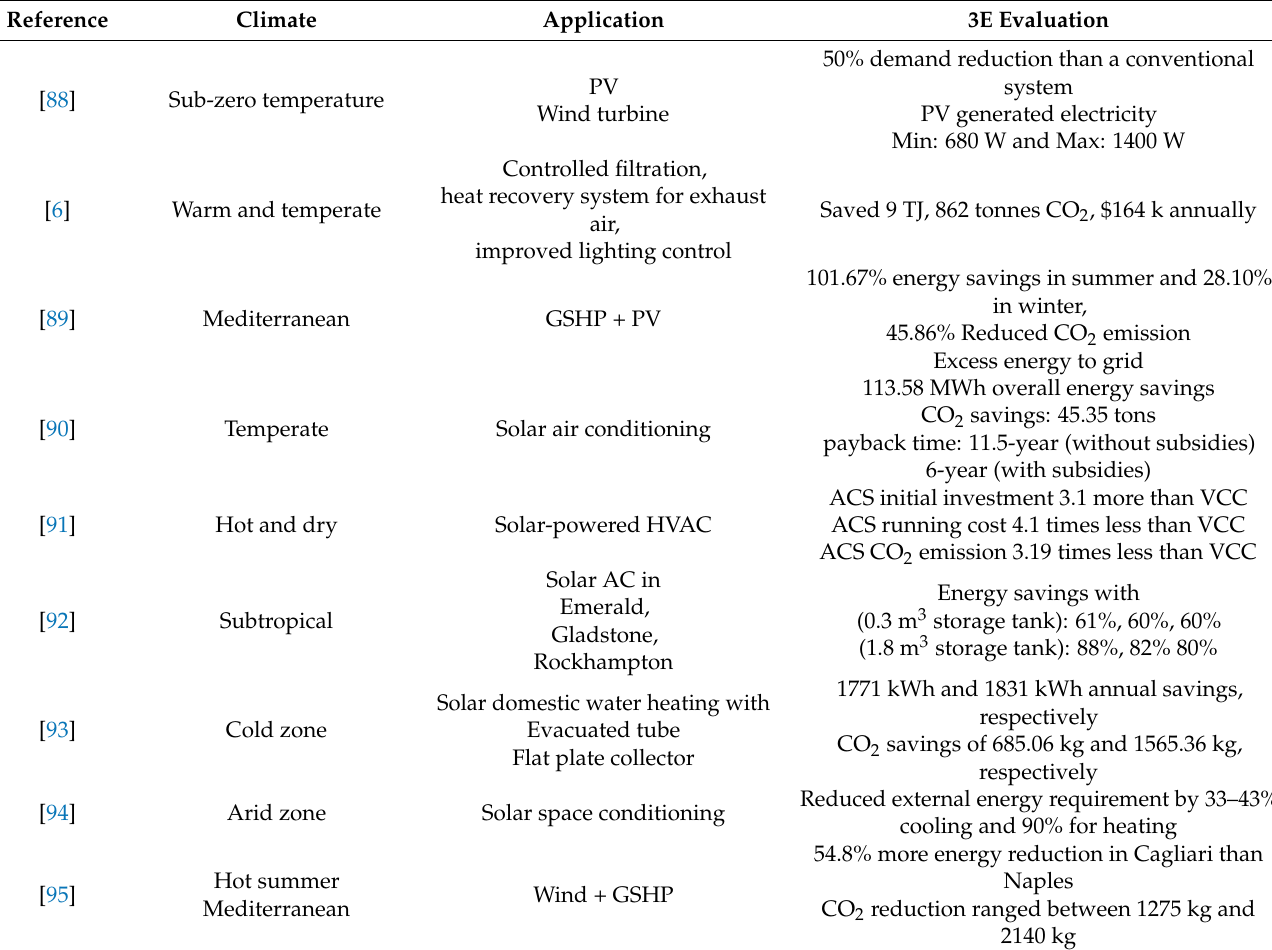
Table 3. 3E evaluation of RES/energy-efficient